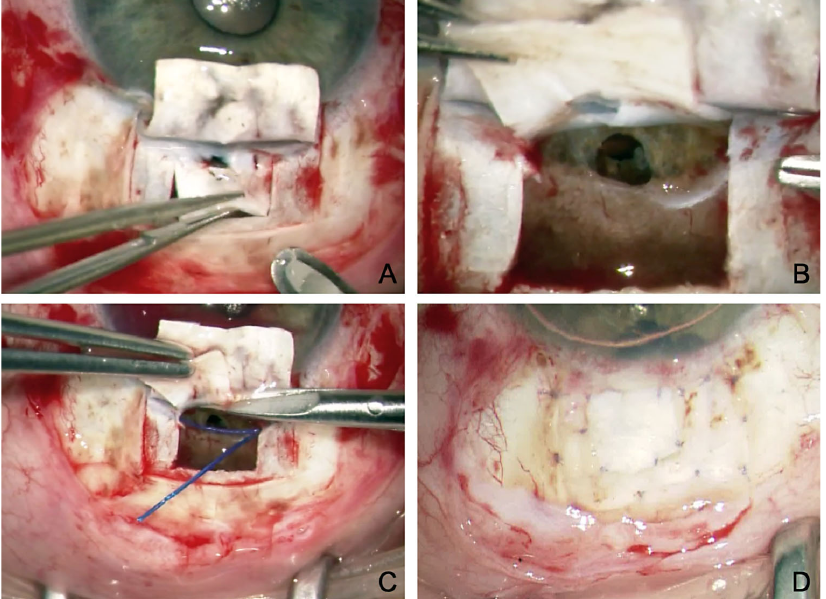
Figure 3. Revision canaloplasty after failed TE. ( A ) Incision and resection of the second deep flap. Note the atrophy in the superficial flap and the defect in the deep flap caused by the previous TE. ( B ) Visualization of the previous TE and iridectomy. ( C ) Probing of the SC on both sides using the suture canaloplasty technique. ( D ) Covering the superficial scleral atrophy with the resected deep scleral flap.